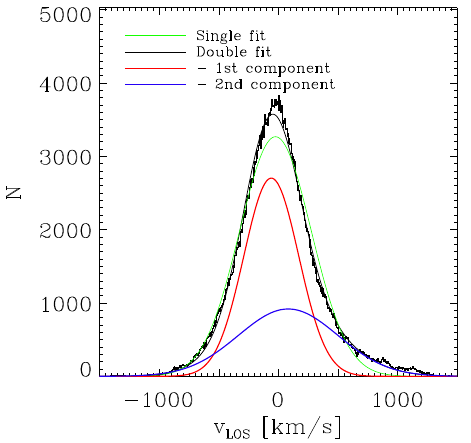
Figure 5. Line-of-sight velocity distributions of the stellar particles (excluding those bound to substructures) of the cluster shown in Figure 1, from a random projection. The green line is the best single Gaussian fit to the distribution, while the black line is the best double-Gaussian fit with its components shown in red and